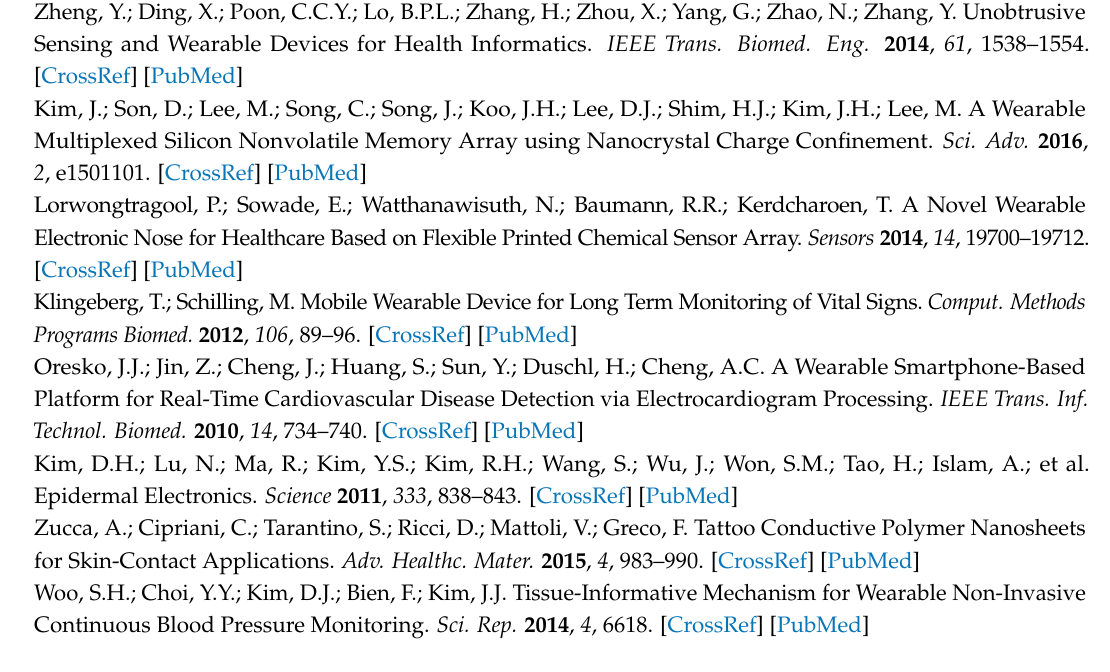
Figure S1: Measured ECG signal at three different levels of motion (standing, walking, and running) for a second subject by using (a) ECG measurement garment without P-electrodes, (b) Ag/AgCl electrodes, and (c) ECG measurement garment with P-electrodes; Figure S2: Measured ECG signal at three different levels of motion (standing, walking, and running) for a third subject by using (a) ECG measurement garment without P-electrodes, (b) Ag/AgCl electrodes, and (c) ECG measurement garment with P-electrodes; Figure S3: ECG signals measured every 3 h for 12 h after application of commercial Ag/AgCl electrodes on